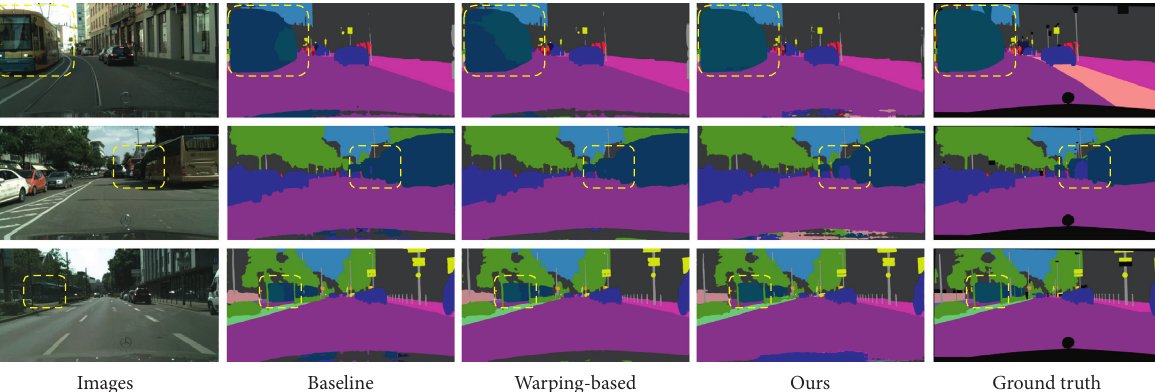
Figure 1: Qualitative results from the Cityscapes dataset. Baseline method: training the model on single frames and inferring the seg- mentation maps on single frames. Warping-based method: adopting the original warping operation implemented with standard bilinear interpolation to propagate and fuse the features brings a slight improvement. Our method: utilizing the flow-guided convolution to adaptively warp the interframe features and introducing temporal consistency loss to explicitly supervise the warped features instead of simple feature propagation and fusion, hence producing more accurate segmentation results.